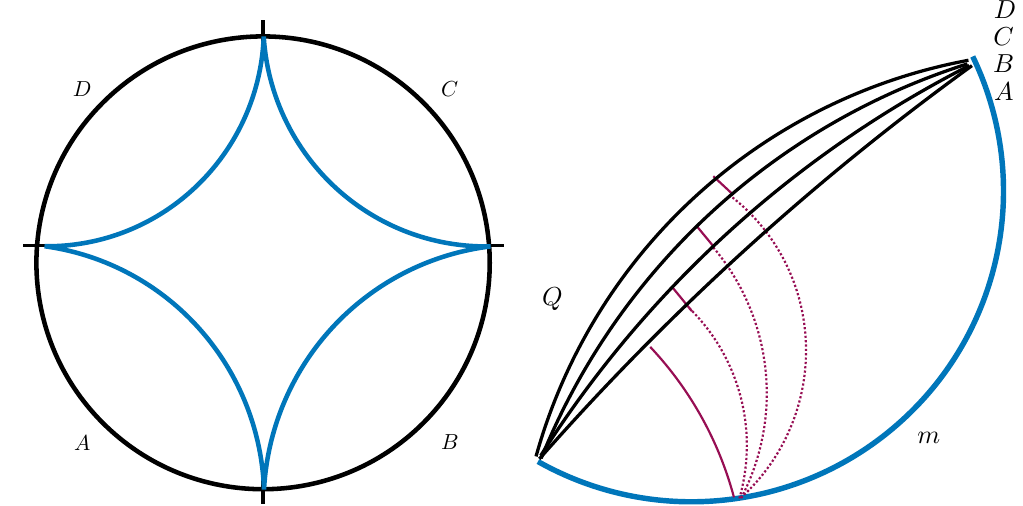
Figure 11 . The space Q is formed by the identification of the surfaces m ( A i ) . A hyperthread on Q can split on the minimal surface m such that it connects to each boundary component. This allows for large amounts of higher party entanglement. The surface m can be thought of as the generalization of a